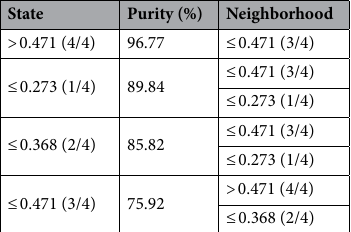
Table 3. Analysis of target node energy with other extracted nodes.